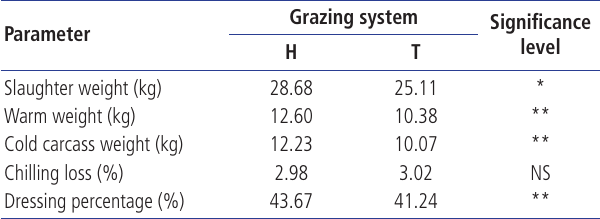
Table 6. Means of carcass characteristics of tethered and herded Nguni goats Grazing system Significance Parameter